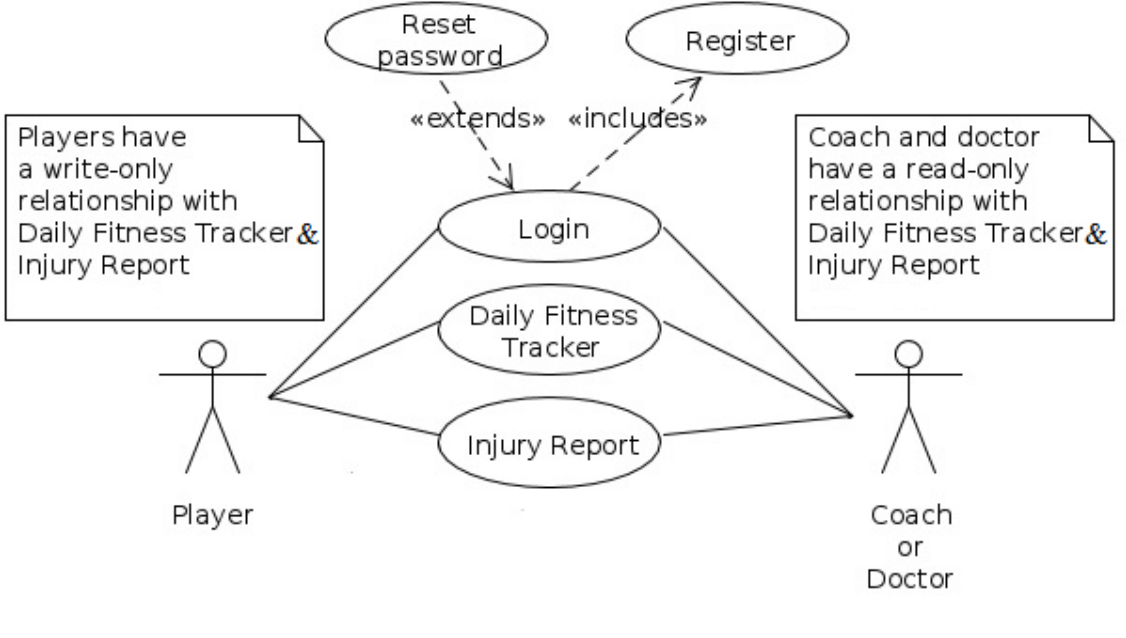
Figure 1. A Unified Modeling Language use-case diagram details the functionality offered to players and